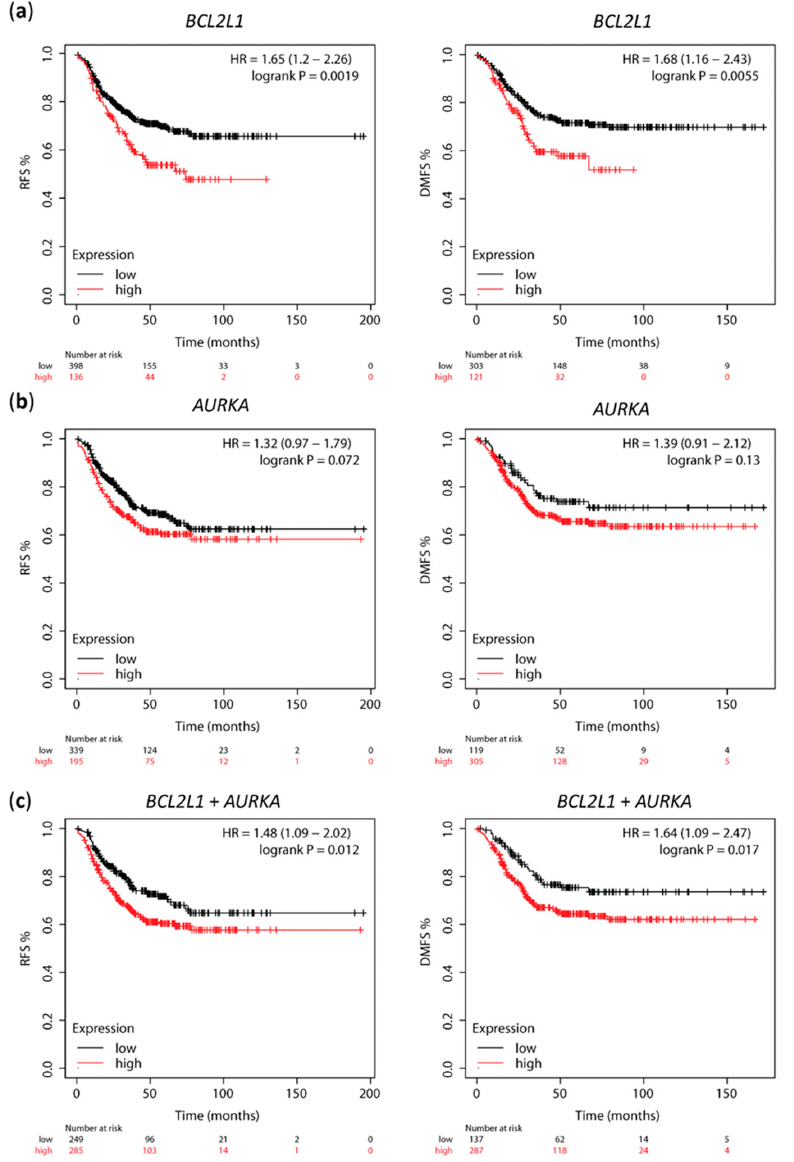
Figure 6. High AURKA and BCL2L1 expression correlates with shorter relapse-free survival (RFS) and distant metastasis-free survival (DMFS) in TNBC. Kaplan–Meier survival curves of RFS and DMFS for ( a ) BCL2L1 and ( b ) AURKA mRNA expression by KM plotter analysis; ( c ) Kaplan–Meier survival curves of RFS ad DMFS for combined BCL2L1 and AURKA mRNA expression by KM plotter analysis.